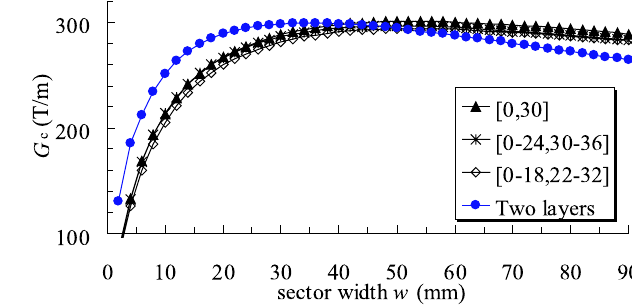
FIG. 11. (Color) Numerical evaluation of the critical gradient versus sector width for different sector